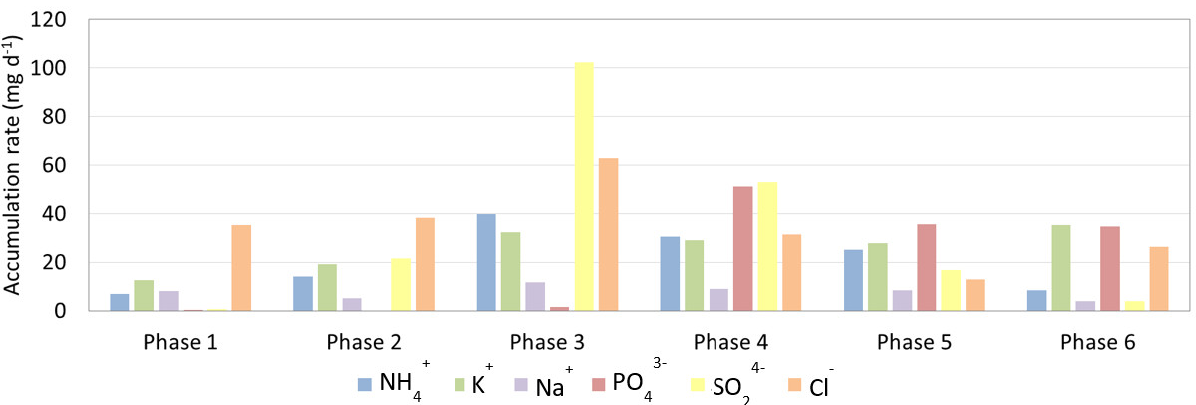
Figure 2. Accumulation rates of NH 4+ , K + , Na + , PO 43 − , SO 24- , and Cl − in the recovery compartment in the different phases. Phase 1: not amended feeding was used; Phase 2: catholyte acidified to pH 6; Phase 3; catholyte acidified to pH 5; Phase 4: catholyte acidified to pH 5 and phosphate amended; Phase 5: phosphate amended catholyte; Phase 6: phosphate amended